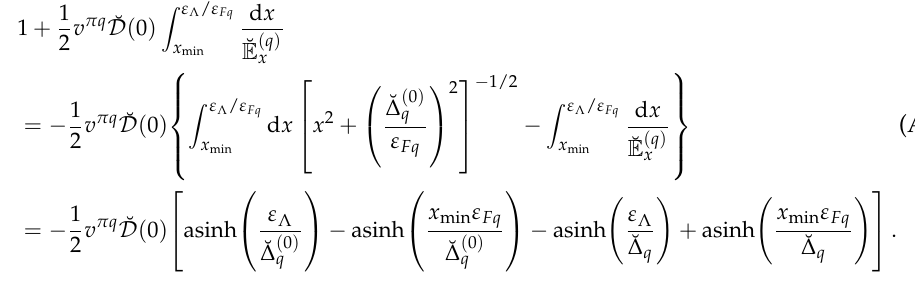
( 0 ) (cid:28) ε Λ , ε Fq allows us to re- q